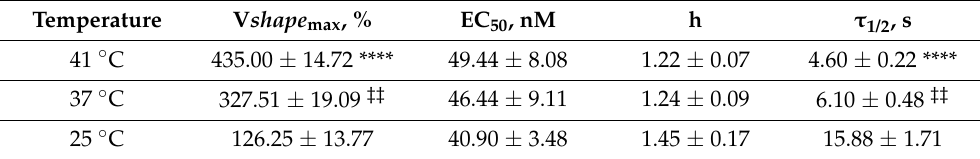
Table 1. Calculated values of the maximal velocity of platelet shape change (V shape max ), EC 50 , Hill coefficient (h), and τ 1/2 at 25°, 37°, and 41 °C.